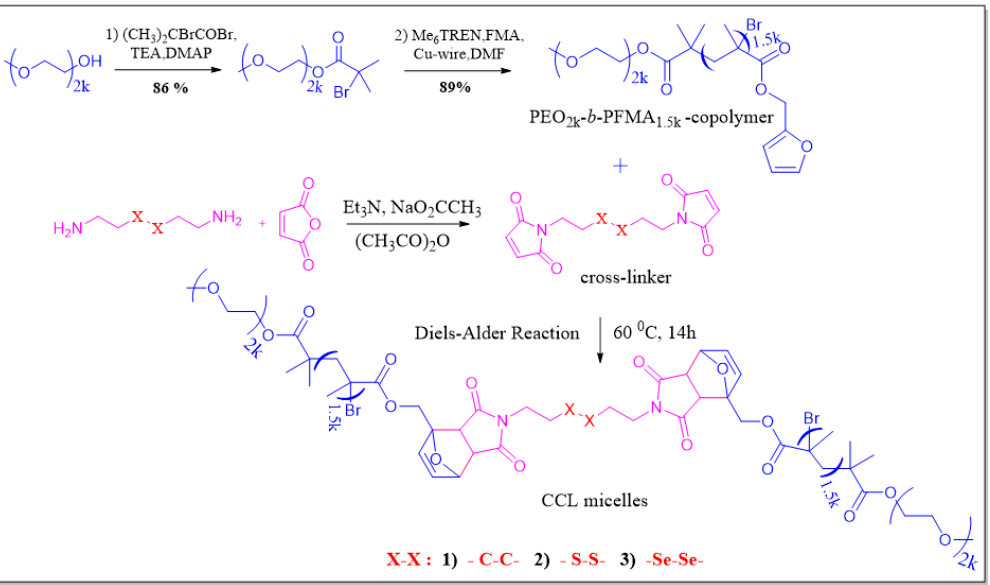
Scheme 2. Preparation of cross-linkers, PEO 2k - b -PFMA 1.5k copolymer, and C–C/S–S/Se–Se CCL